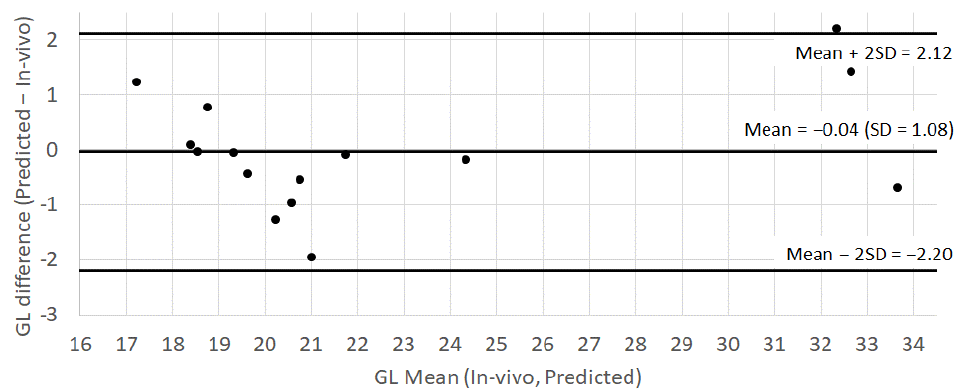
Figure 3. Bland – Altman plot comparing the in vivo GL estimates and the eGL predicted from the nutritional composition of 15 samples, each of them being represented by a black dot (studies A, C and D) .